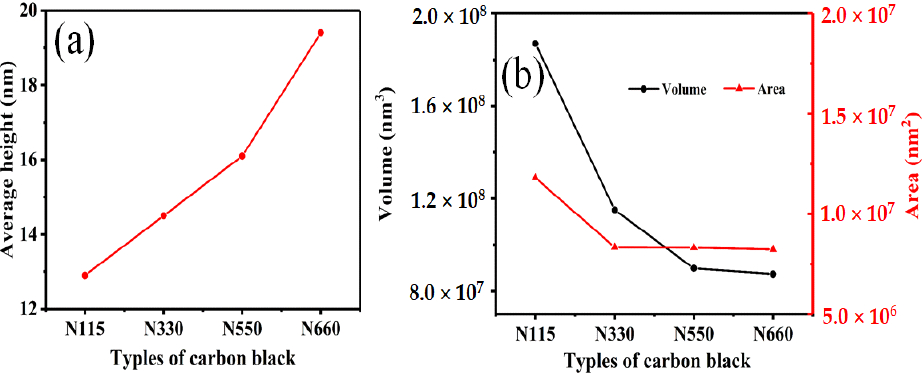
Figure 2. ( a ) Average protruding heights of N115/NR, N330/NR, N550/NR, and N660/NR in the area of 1000 nm × 1000 nm. ( b ) The extruded volume and area of N115/NR, N330/NR, N550/NR, and N660/NR in the area of 1000 nm × 1000 nm.